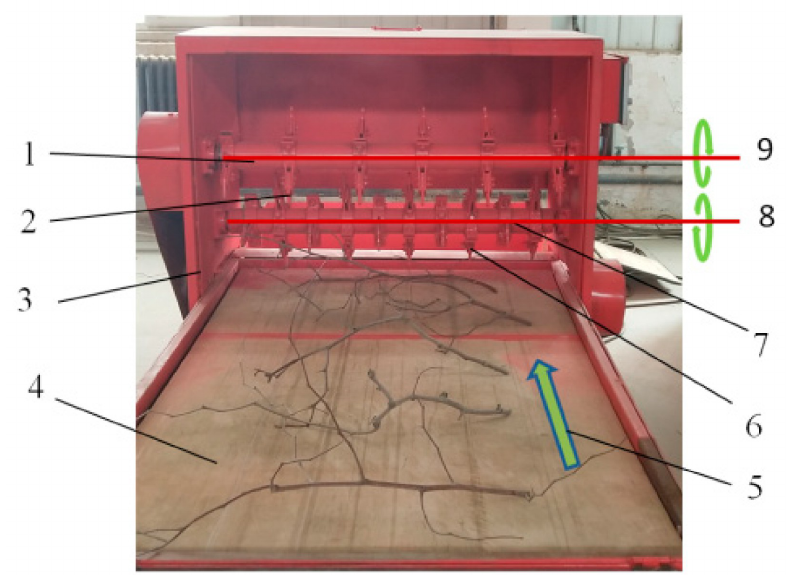
Figure 12. Prototype of jujube branch picking mechanism. 1. Upper gear shaft 2. Upper gear 3. Device shell 4. Conveyor 5. Movement direction of conveyer belt 6. Lower gear 7. Lower gear shaft 8. Counterclockwise rotation 9. Clockwise rotation.